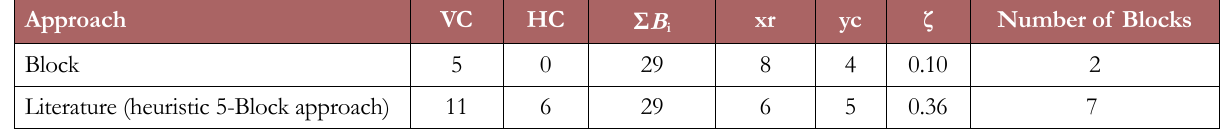
Table 3. Complexity Index for Instance